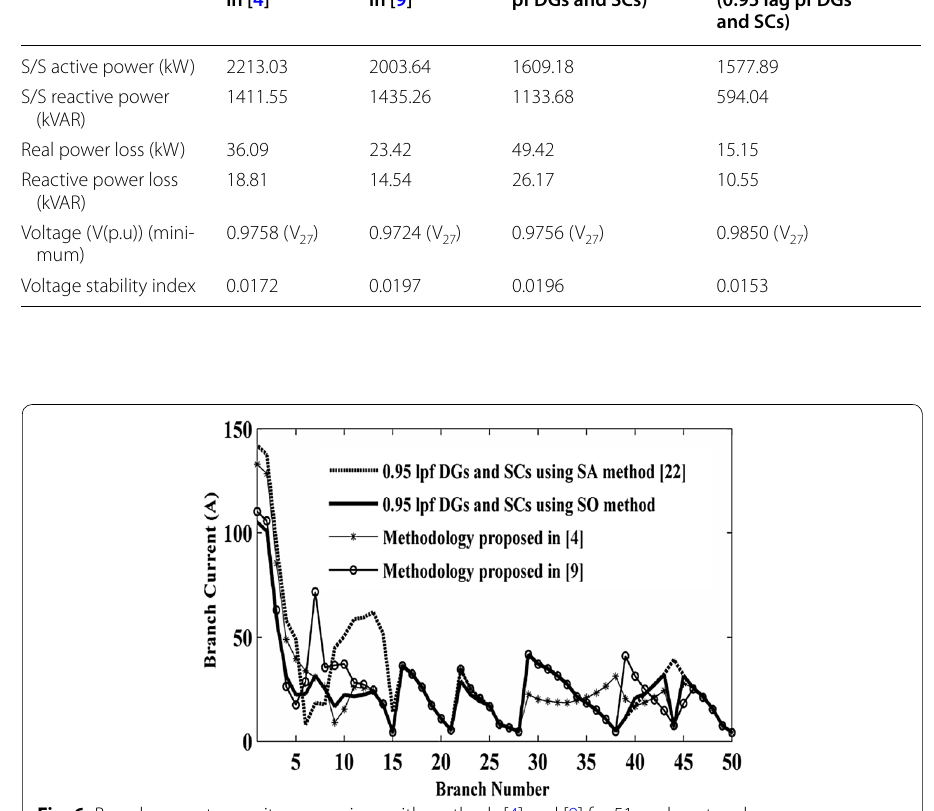
Fig. 6 Branch current capacity comparison with methods [4] and [9] for 51-node